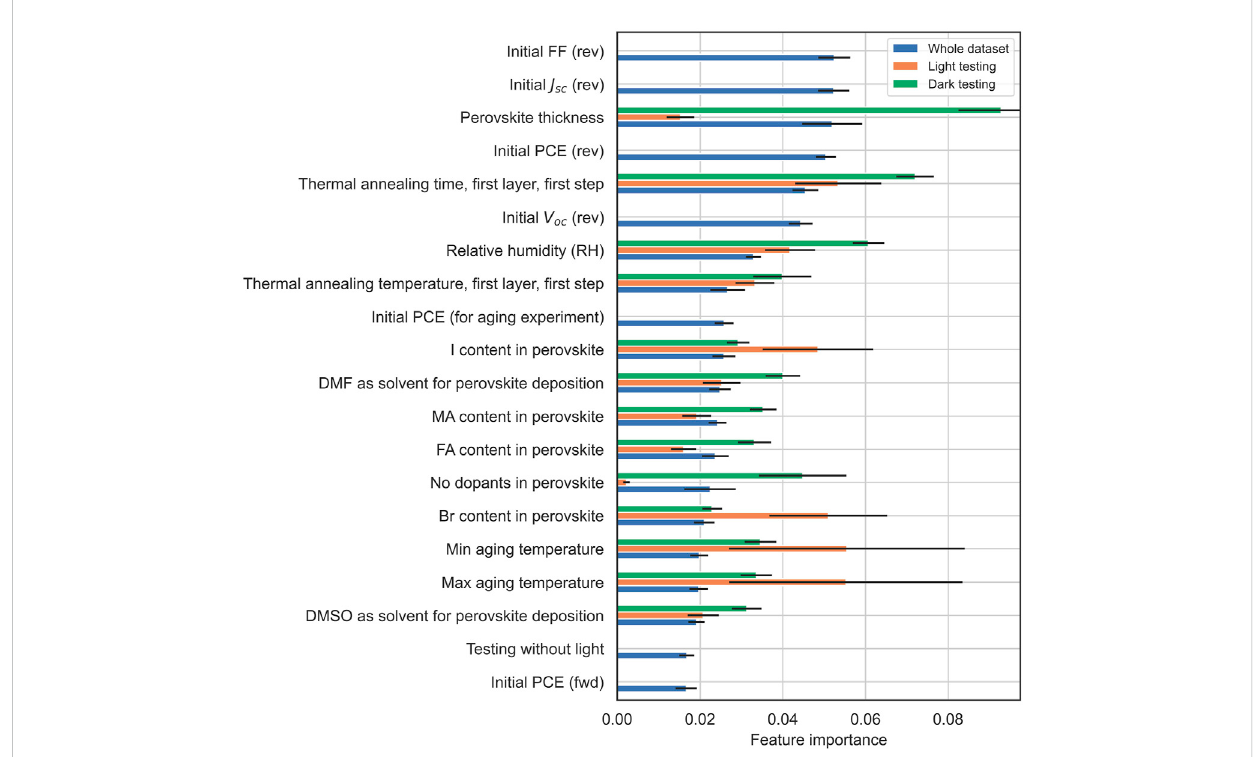
FIGURE 8 Feature importance for the Random Forest model. The different colors identify the possible dataset splits. We show the 20 most important features when modeling the complete dataset.